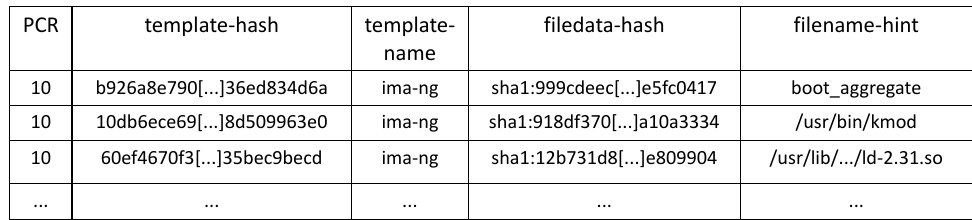
Figure 2. Excerpt of IMA Measurement Log according to ima-ng